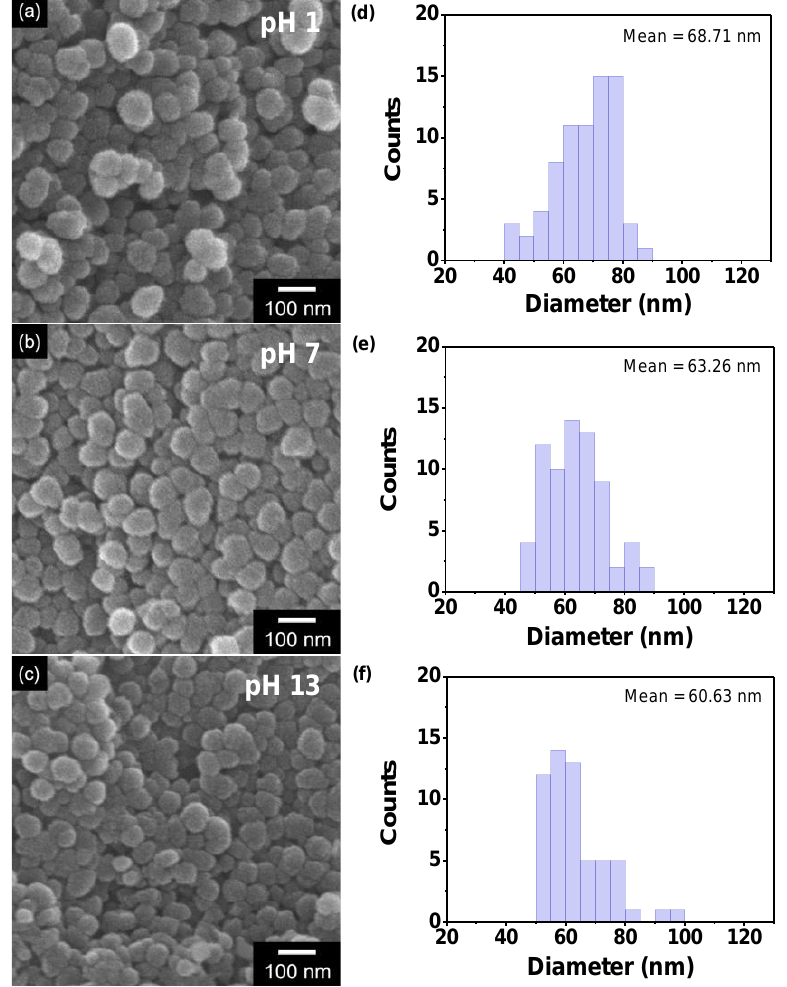
Figure 4. ( a – c ) Field emission scanning electron micrographs of PPyNPs and ( d – f ) size distribution of the nanoparticles within a unit area (1 µm × 1 µm) at different pH values (( a , d ): pH 1; ( b , e ): pH 7; ( c , f ): pH 13).